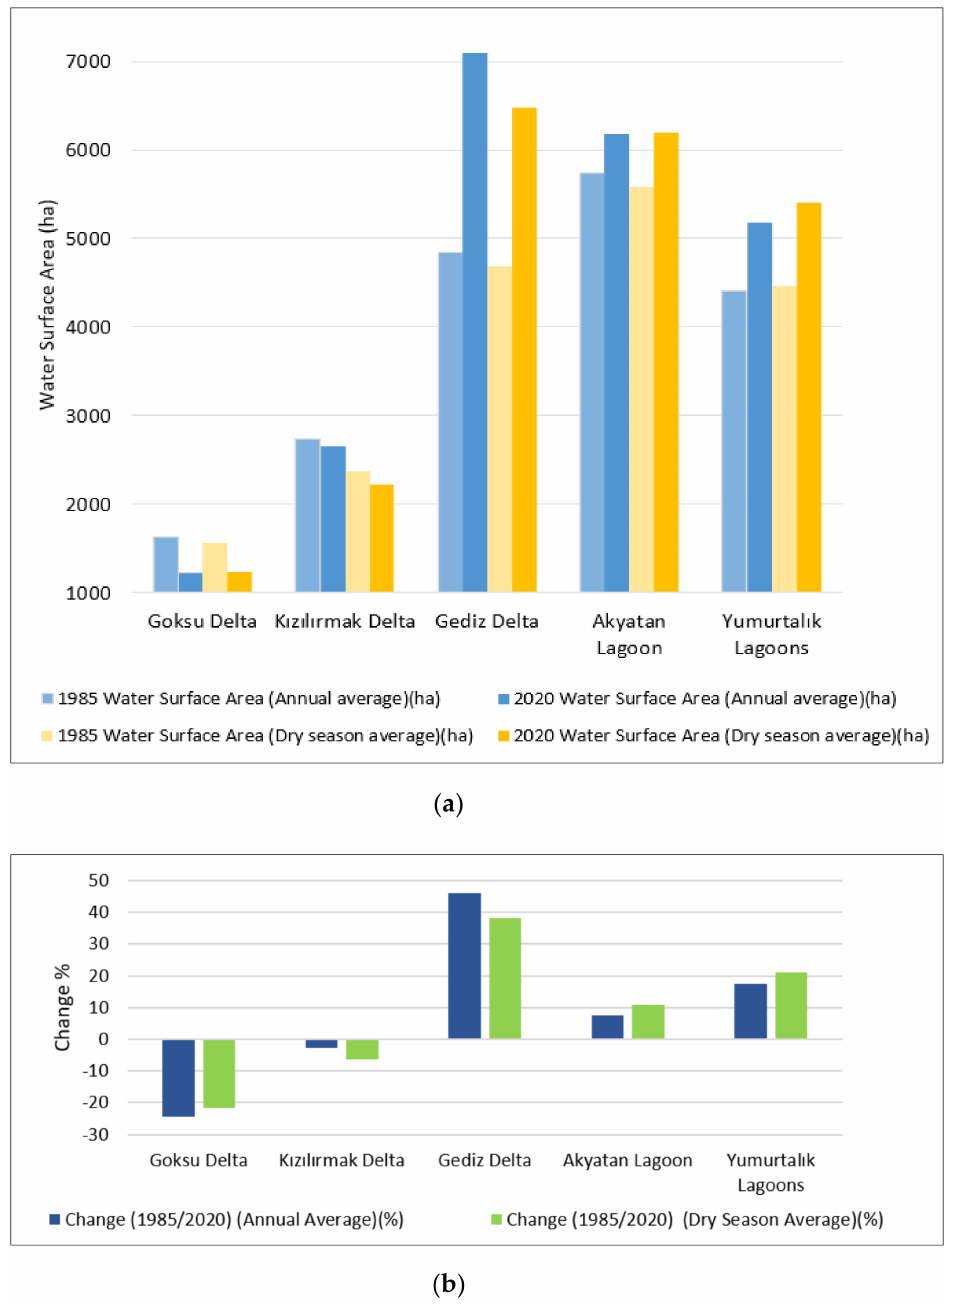
Figure 8. ( a ) Water Surface Areas (Annual and Dry Season Average) at Turkey’s Coastal Ramsar Sites in 1985 and 2020 ( b ) %